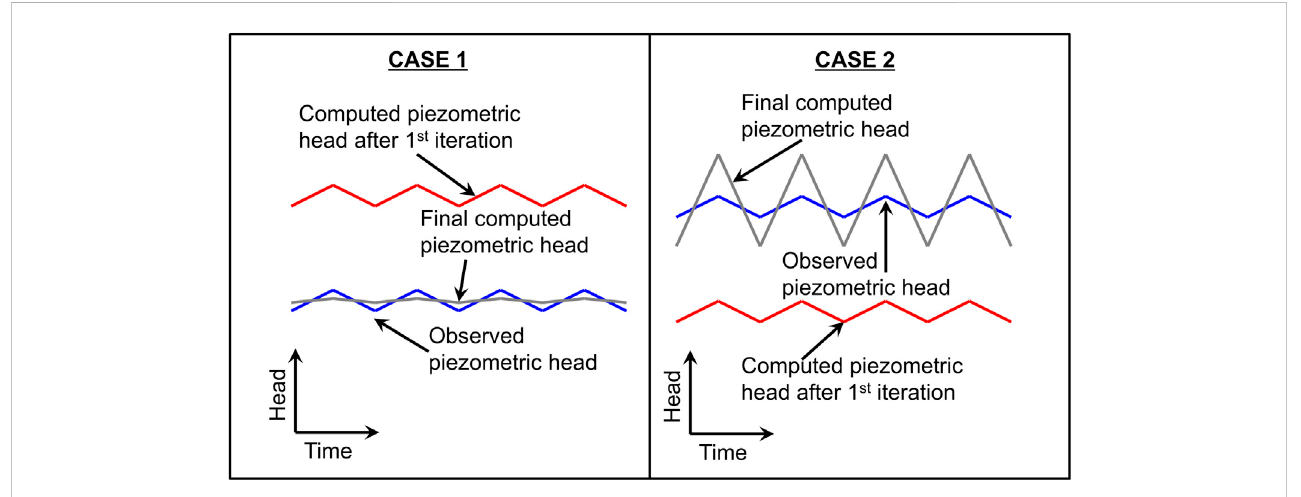
FIGURE 8 Situations that may arise when the numerical model assigns an observation point to the nearest